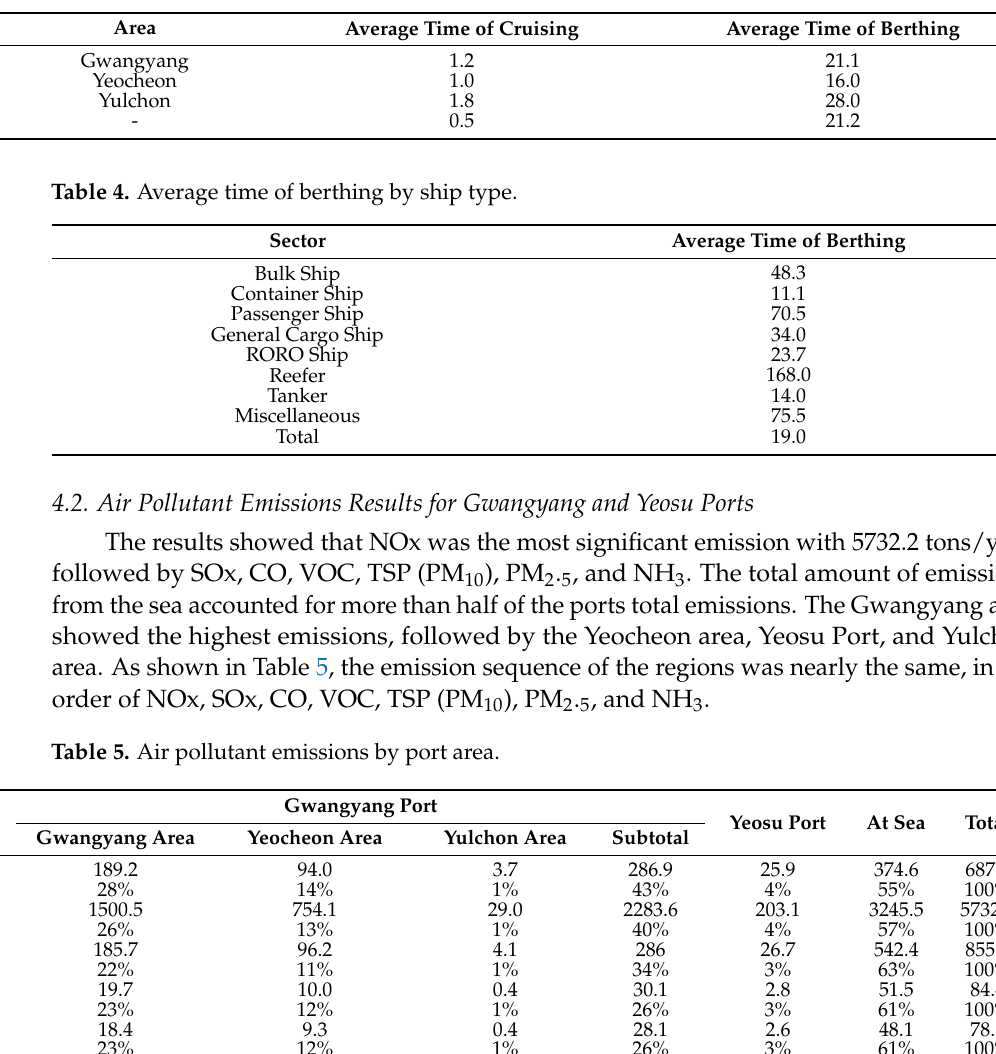
Table 3. Average time of cruising and berthing by area.